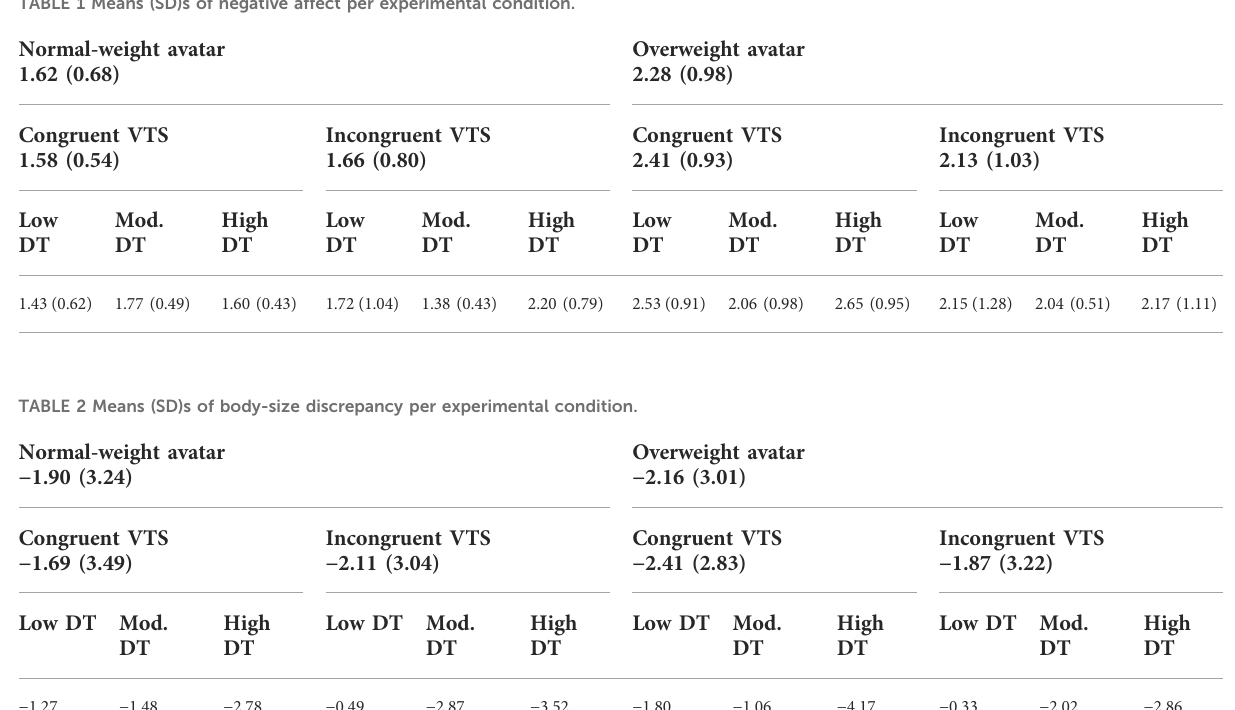
TABLE 1 Means (SD)s of negative affect per experimental condition.